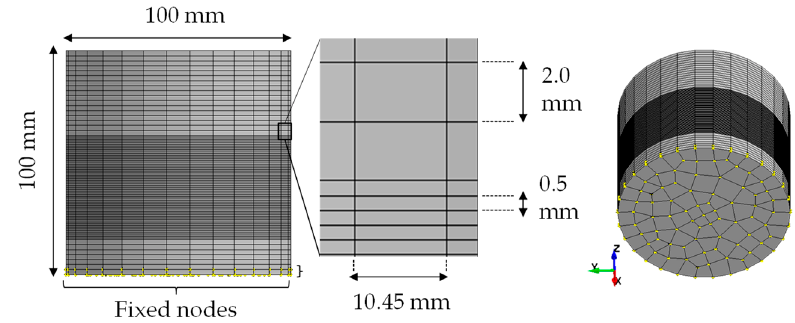
Figure 4. Dimensions, mesh-size, and position of the fixed nodes of the tool (cylinder).